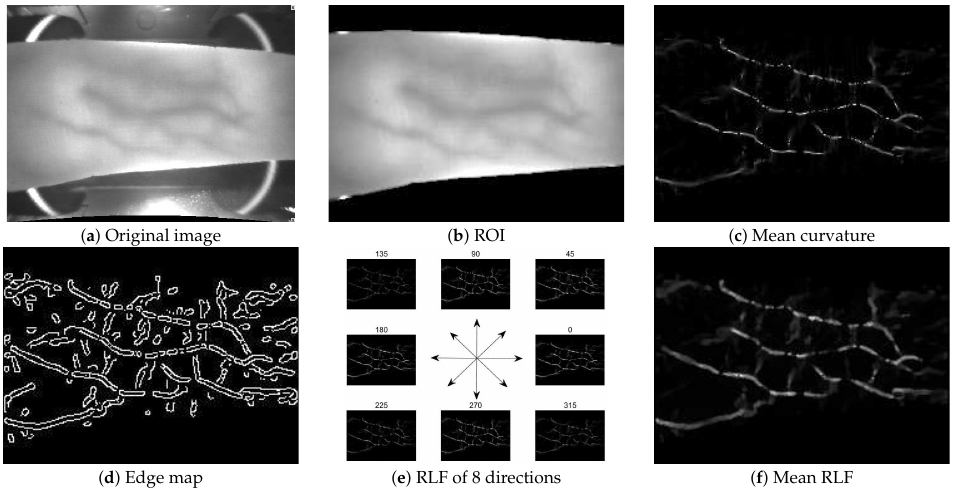
Figure 4. An implementation example of the proposed Radon-like features. ( a ) Original finger vein (FV) image; ( b ) region of interest (ROI) result; ( c ) mean curvature result; ( d ) edge map of mean curvature image; ( e ) scan lines of eight directions; ( f ) mean RLF